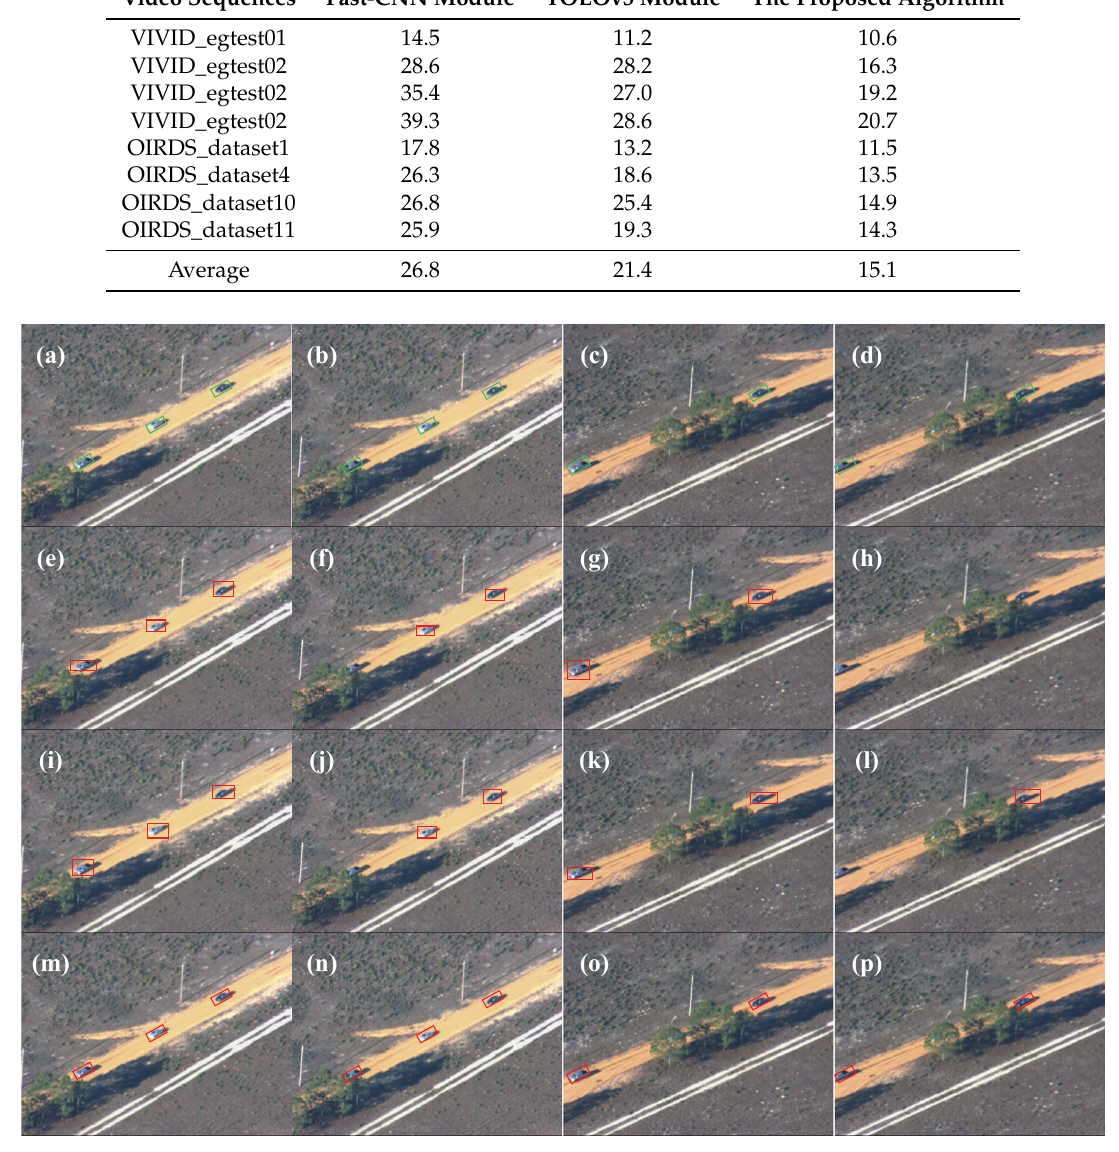
Figure 8. Comparison of partial occluded vehicles detection for the VIVID data set. ( a – d ): Ground truth, ( e – h ): Fast-CNN module, ( i – l ): YOLOv3 module, ( m – p ): Improved YOLOv3